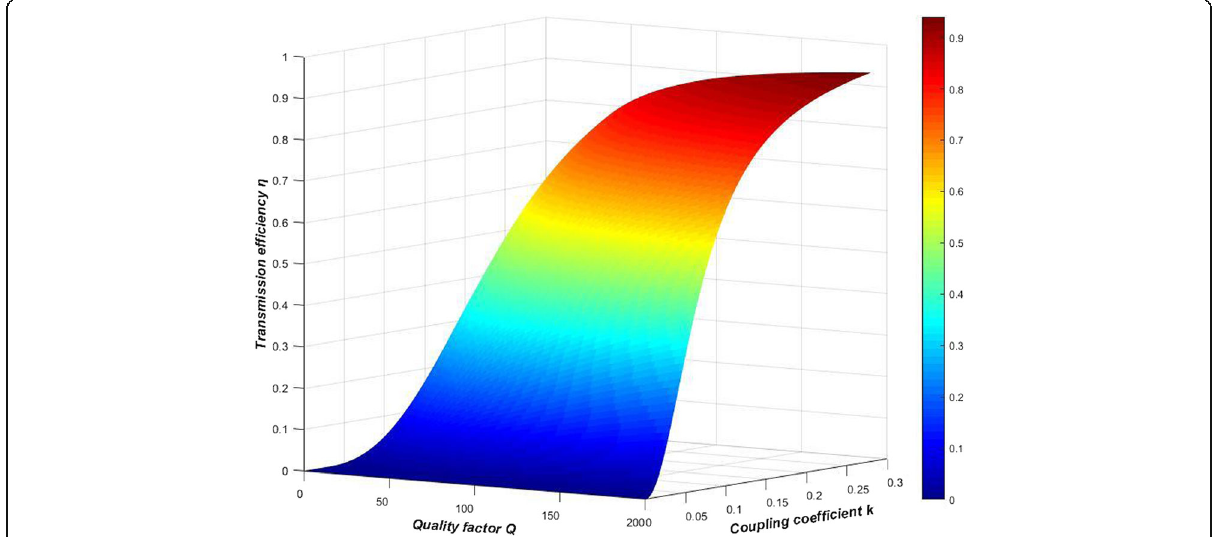
Fig. 6 Influence curve of quality factor and coupling factor on transmission efficiency